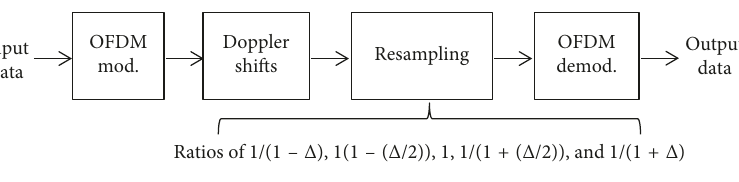
Figure 7: Resampling